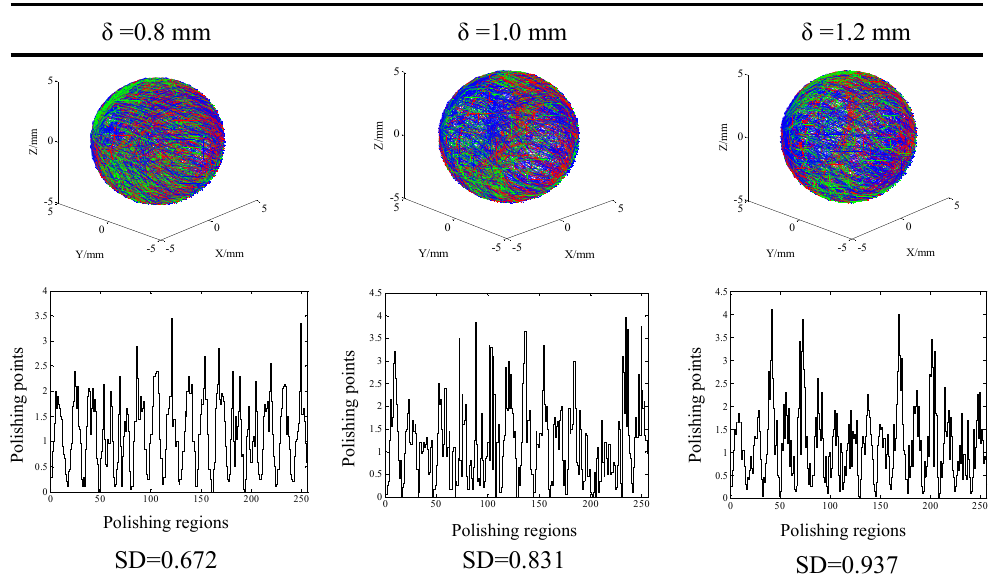
Figure 12. Distribution of the finishing traces at different gaps when rotating ratio and eccentricity were fixed ( e = 10 mm, r = 3/4).